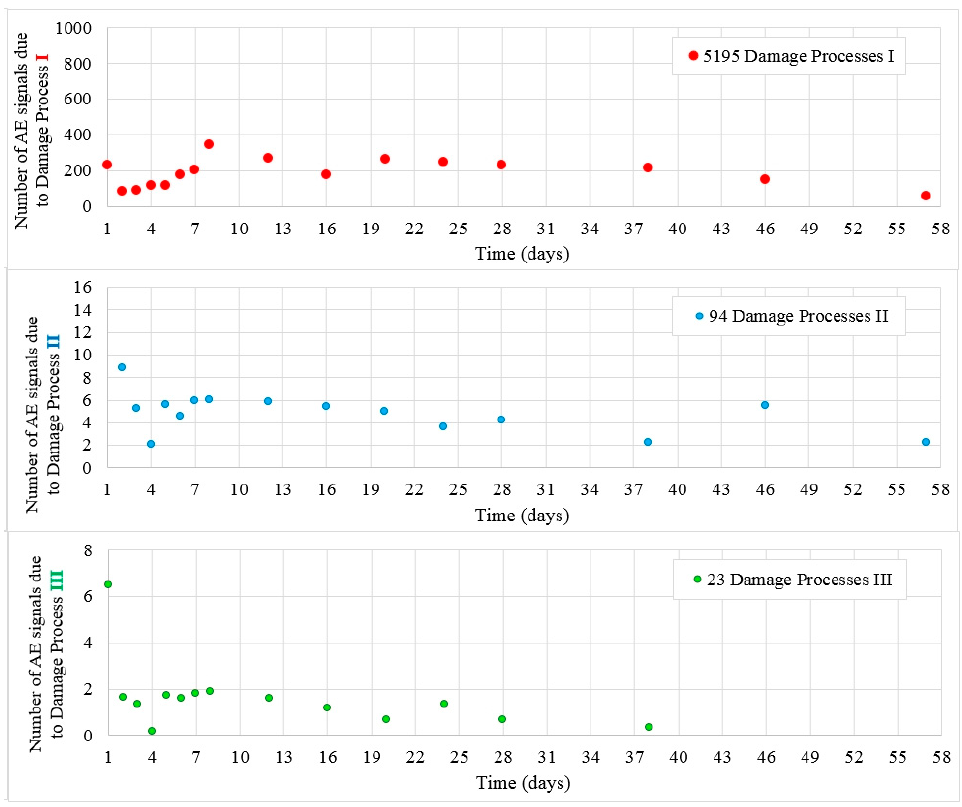
Figure 5. Number of damage processes I–III obtained from W3 samples.